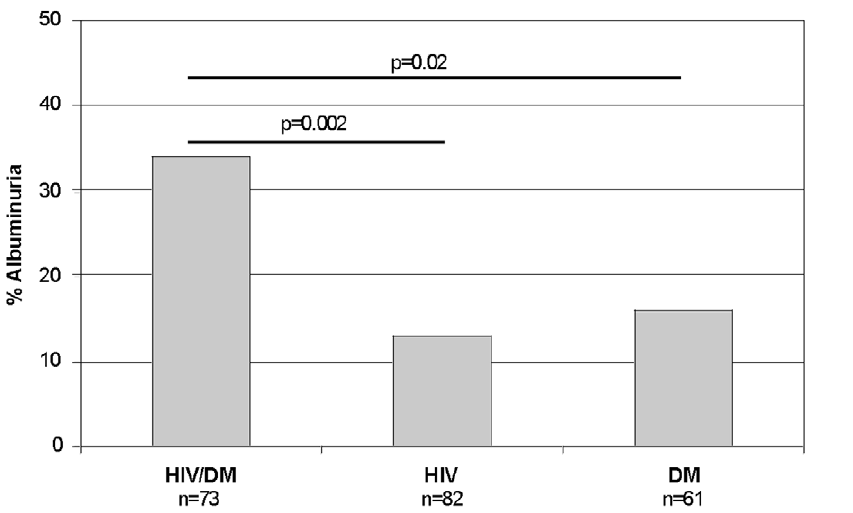
Figure 1. Prevalence of microalbuminuria in HIV-infected subjects with diabetes (HIV/DM), HIV-infected subjects without diabetes (HIV) and subjects with diabetes without HIV infection (DM). P values represent pairwise comparisons by chi-square.